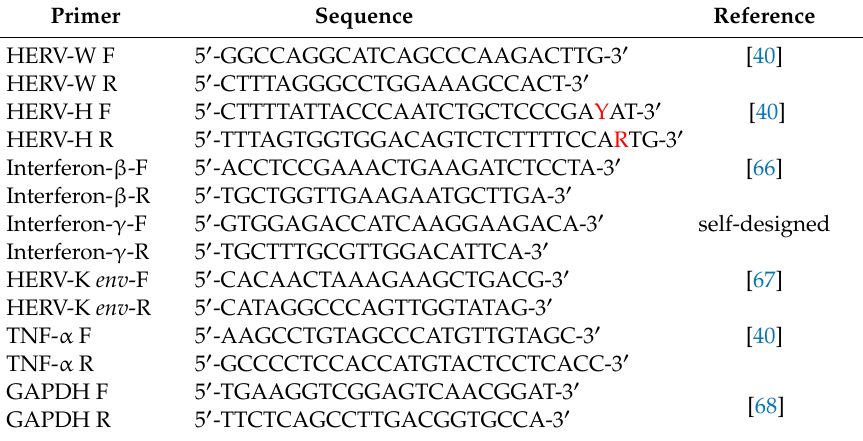
Table 2. Sequences of primers used in qPCR amplifications. Nucleotide ambiguities are labeled in red (Y = C or T; R = A or